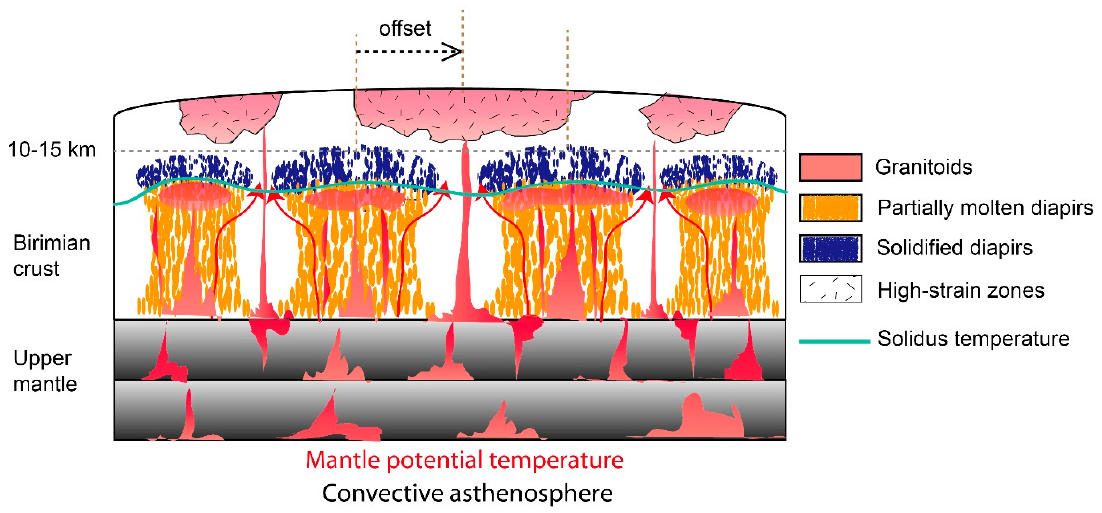
Figure 15. Sketching the scenario of greenstone ‐ granitoid belts during the Eburnean Orogeny. Diapirs are made of upper solidified lids and partially molten lower crust rocks. This feature results from the distribution of solidus temperature of the lower crust (light green line) according to the numerical results in Figure 14. We suggest that a series of sheet ‐ like granitoids possibly derived from either subducted mélanges, lower crust and/or mantle melting accumulated at depths of the subcontinental mantle would canalize along diapirs before feeding the upper crust. When the granitoids arrive at the solidified lids of the diapirs, they would favour migrating horizontally and intruding into the upper crust through weakening zones between the diapirs. This model also suggests a dissymmetry of structures between the upper and middle ‐ lower segments of crust, with the dome ‐ like granitoids overlying high ‐ grade sedimentary synforms and high ‐ grade diapirs underlying low ‐ grade greenstone belts. Red = granitoids; orange = partially molten materials of diapirs (lower part); blue = solidified lids of diapirs (upper segment); light green line = solidus temperature of lower crust (Figure 14c).